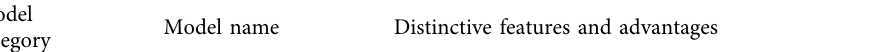
Table 1: Car-following